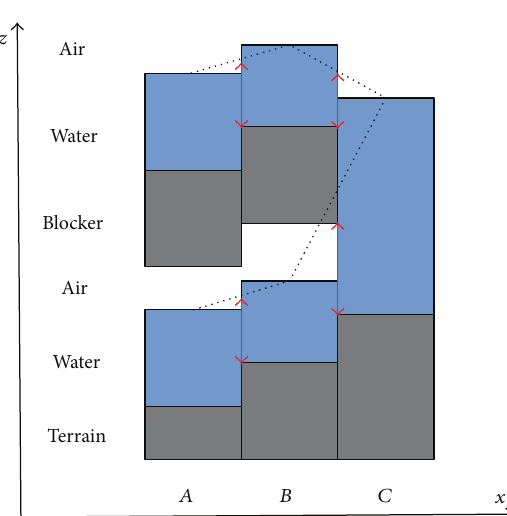
Figure 2: A side view of the model structure. Cells 𝐴 and 𝐵 have a blocker column with water and air also below the blocker. Cell 𝐶 is free and thus has only a single water column. Intervals that are used for flow calculation are marked with red arrows. The top of the interval is the average of the two water surfaces. The blockers are taken into account; for example, the bottom flow between 𝐵 and 𝐶 is partly blocked.